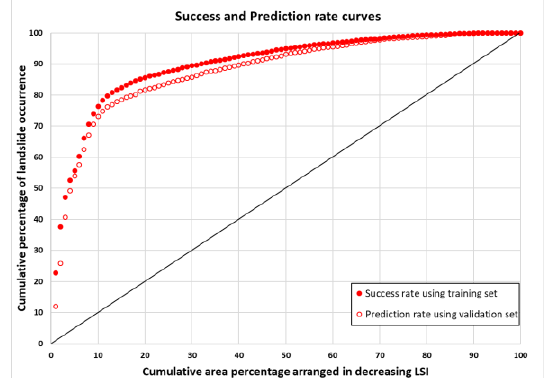
Figure 6. Success (filled circle) and Prediction rates (open circle) of frequency ratio model using twelve landslide conditioning factors derived from DEM, map and high- resolution satellite